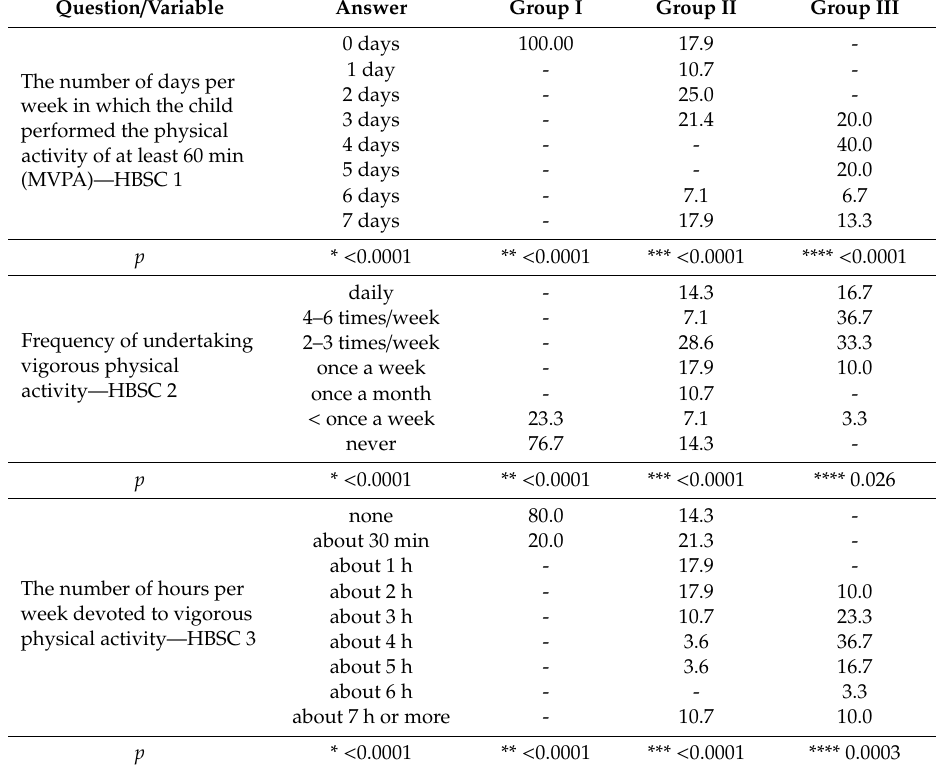
Table 3. Physical activity level in children. The percentage of the respondents providing a given answer